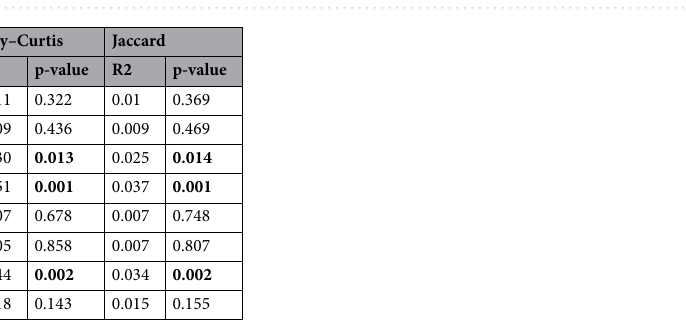
Figure 2. Ordination plot for the first two principal coordinates based on Bray–Curtis (upper plots) and Jaccard (lower plots) dissimilarities reported by, from left to right, maternal antibiotic exposure ( a , d ), delivery mode ( b , e ) and gestational age ( c , f ). For simplicity of graphical representation, gestational age is reported using quartiles.